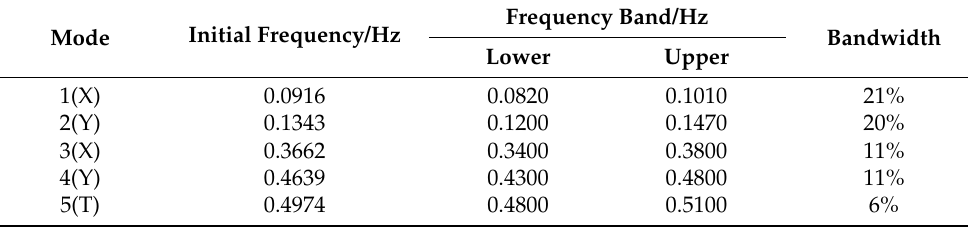
Table 6. Initial frequency and frequency band by the FBFFT method of the Canton Tower.